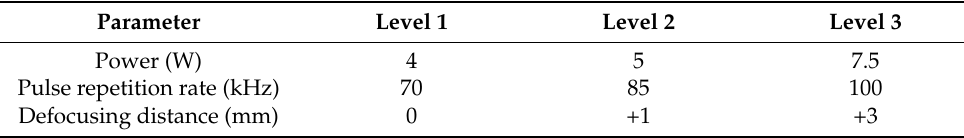
Table 1. Parameters of experiments and